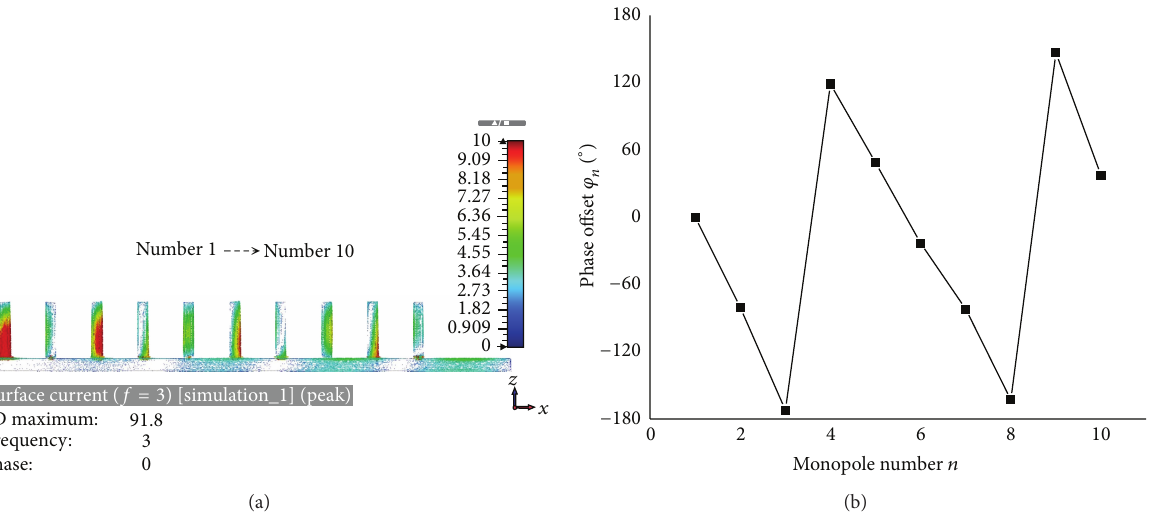
Figure 4: The current distribution on the 10-element monopole end-fire array with a finite ground 𝐿 𝑎 = 200 mm, 𝐿 𝑔 = 30 mm, and 𝑊 = 60 mm at 𝑓 = 3 GHz for a certain phase step Δ𝜑 0 : (a) current vector on the surface, (b) actual current phase offsets of elements.